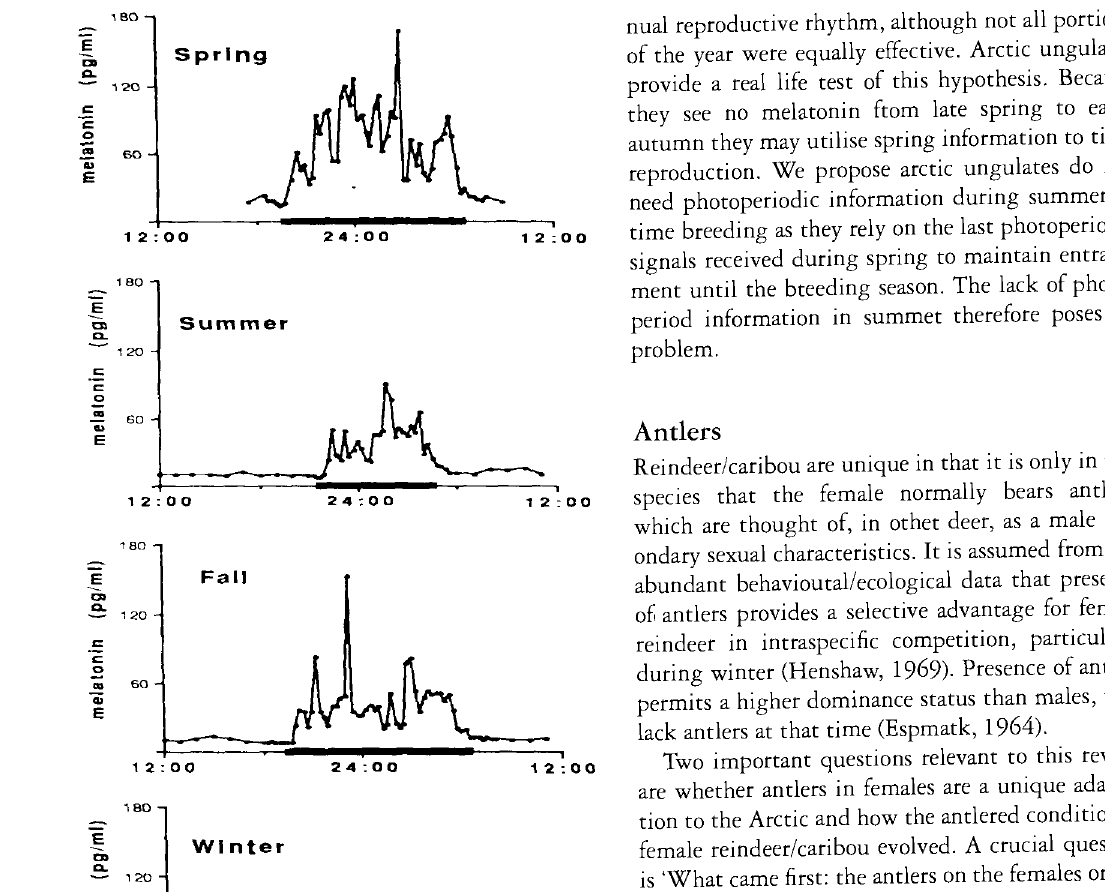
Fig. 2. Melatonin secretion during four seasons of the year in muskoxen (after Tedesco et al, 1992).